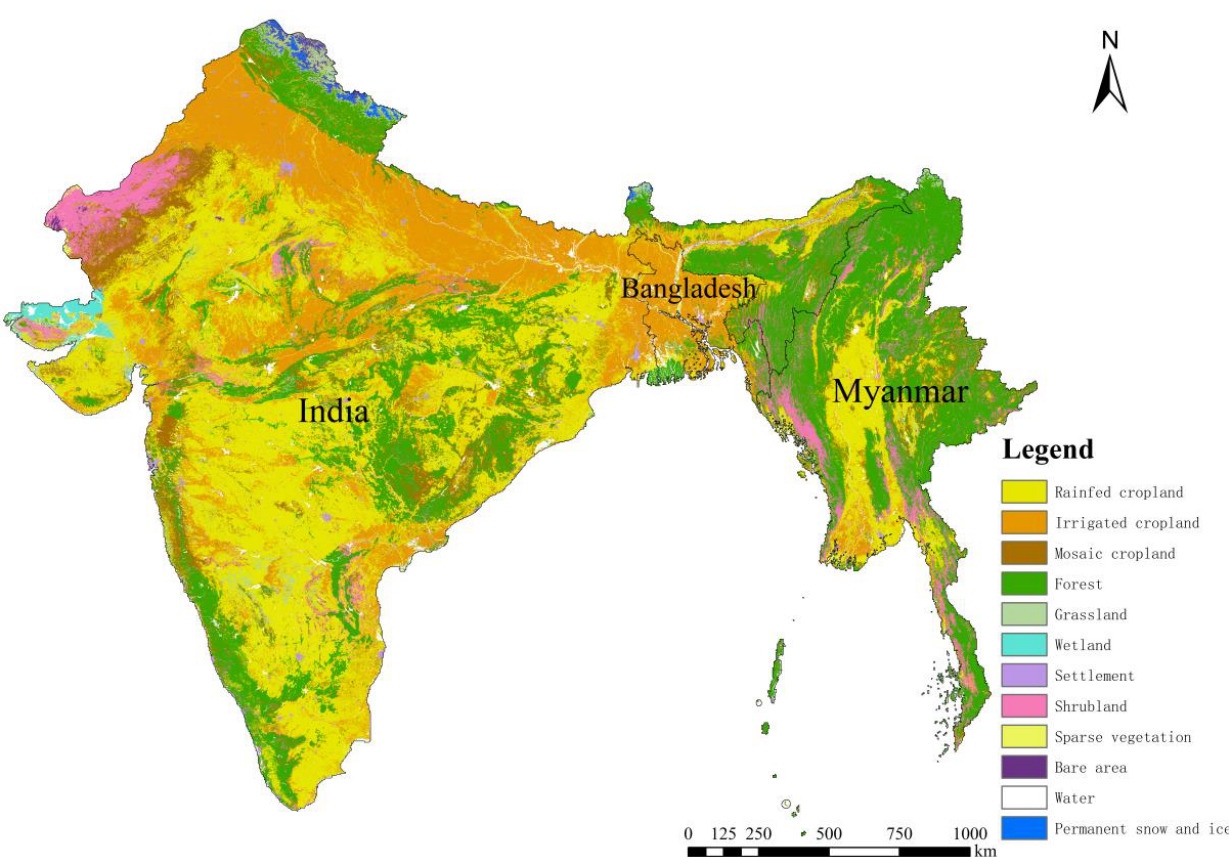
Figure 1. Types of land use in the study area.